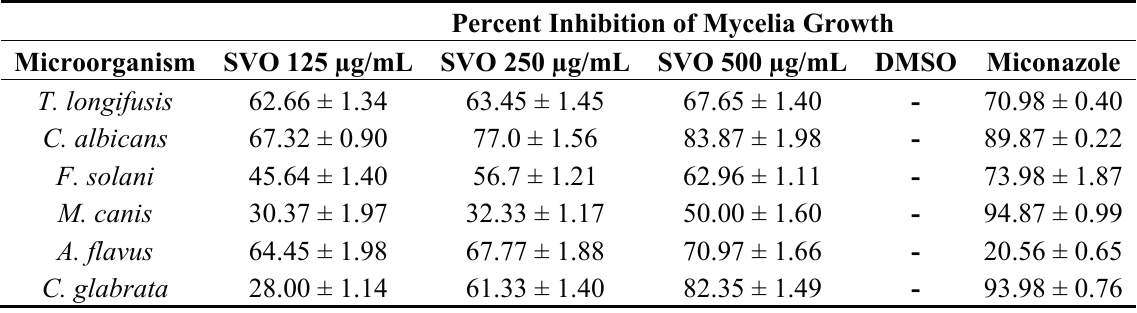
Table 3. Antifungal effect of the essential oil of the leaves of Skimmia laureola (SVO).